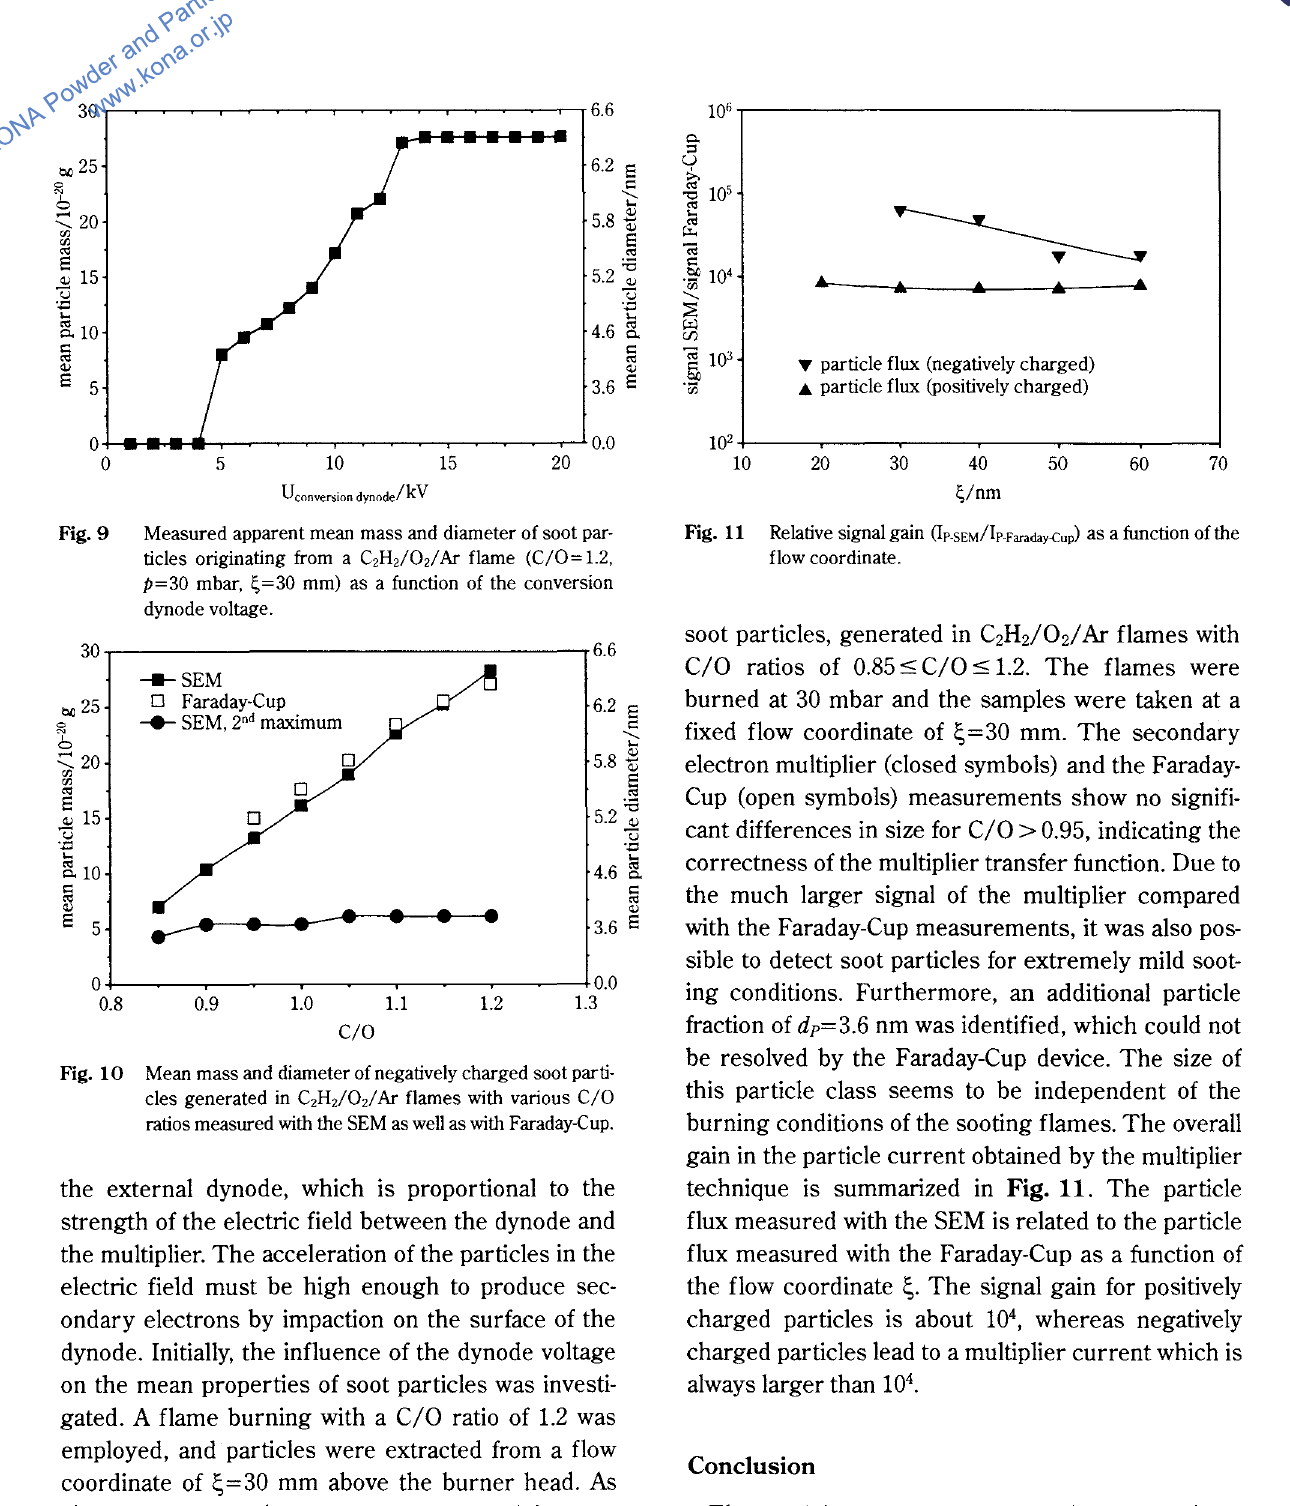
Conclusion The particle mass spectrometer (PMS) has been successfully applied to four different aerosols gener ated under different conditions in various pressure ranges. Soot as well as ceramic or metallic particles were generated in low-pressure flames, microwave plasma, and electric sparks, yielding particles in the size range of 1 to 10 nm. The only conditions of opera tion are that the process is stationary over a sample time of about two minutes and that the process